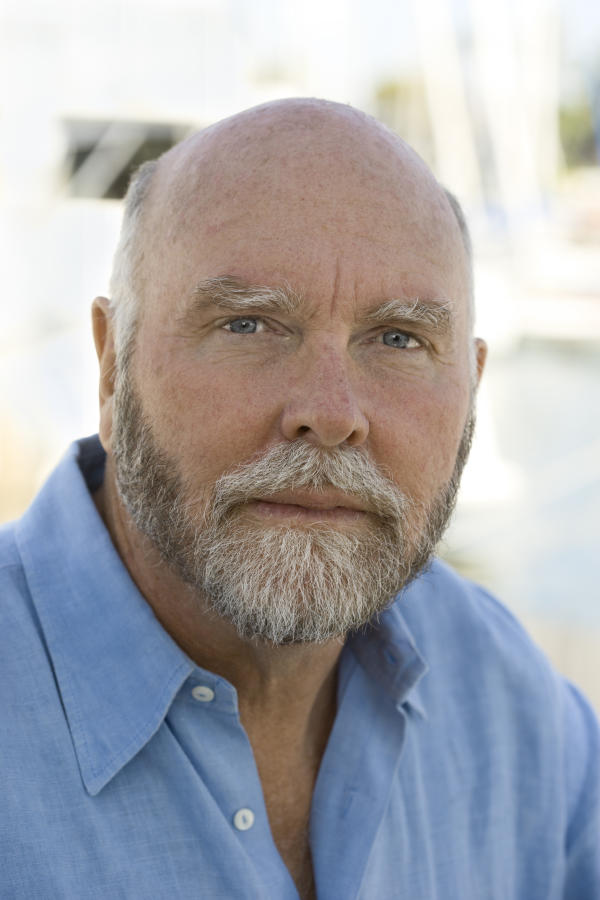
J. Craig Venter (above) led the effort, and donated his DNA, to sequence and assemble the complete genome of a single individual.